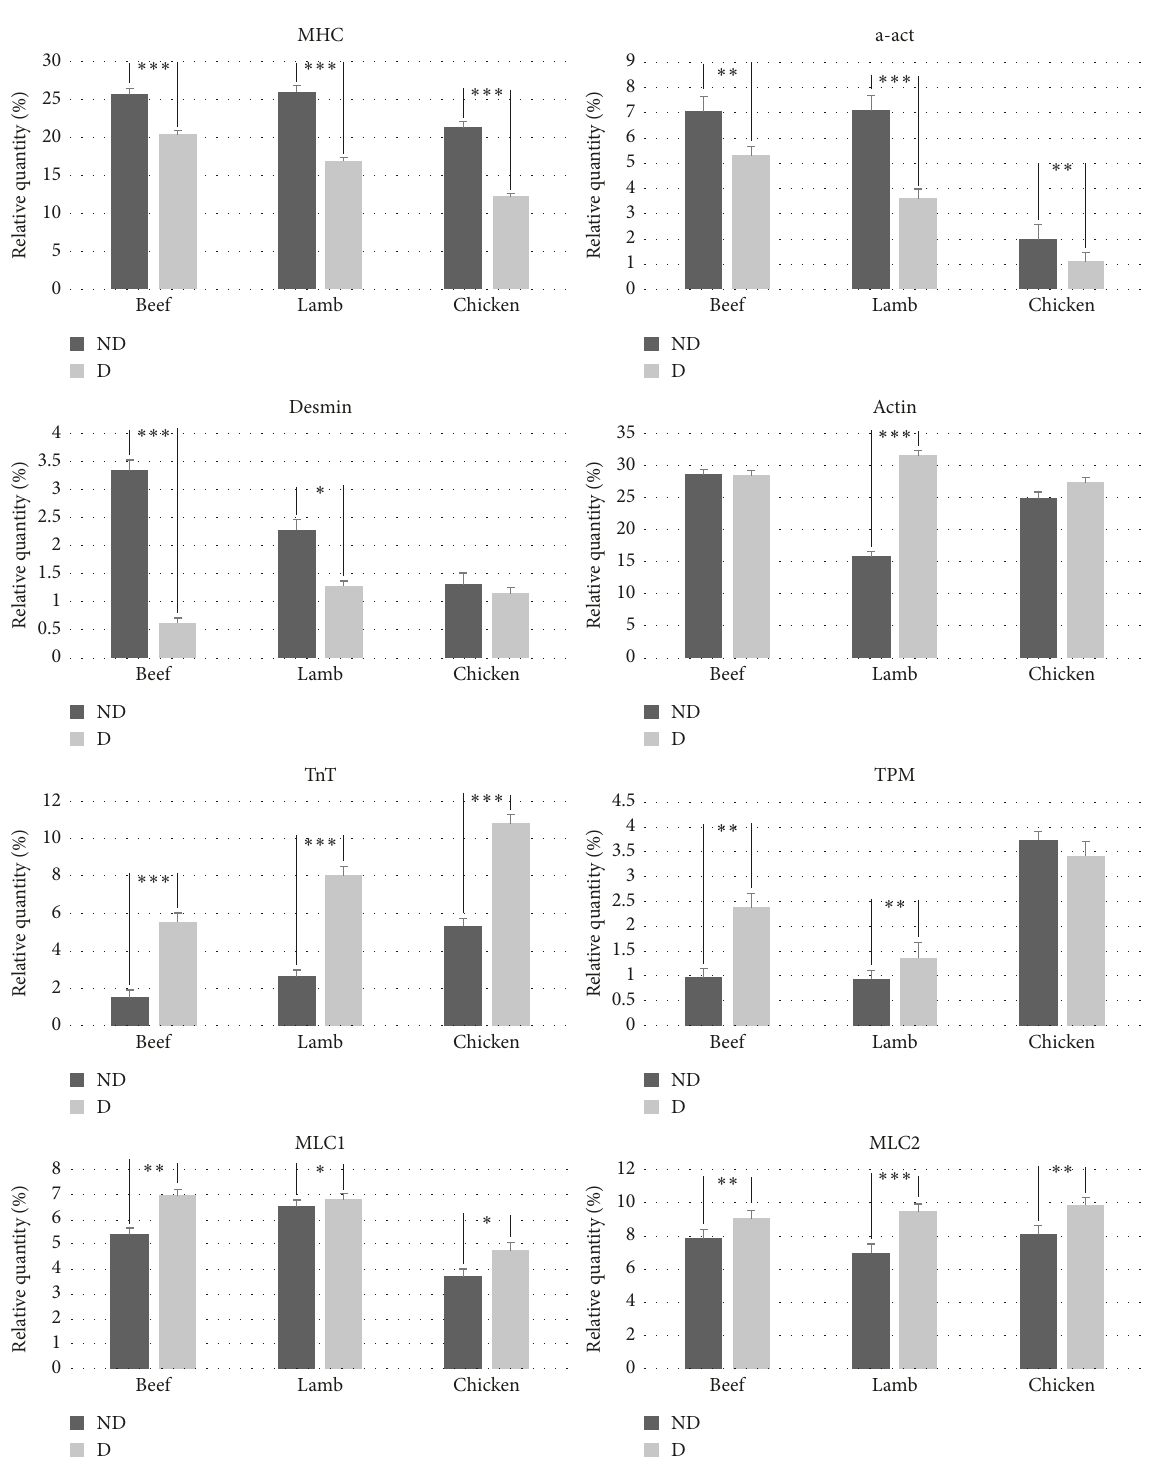
Figure 5: Percentage of the main myofibrillar proteins from beef, lamb, and chicken samples extracted with denaturing and nondenaturing solutions (D � denaturing; ND � nondenaturing; MHC � myosin heavy chain; a-act � α -actinin; TnT � troponin T; TPM � tropomyosin; MLC1 � myosin light chain 1; MLC2 � myosin light chain 2; ∗ P < 0 . 05; ∗∗ P < 0 . 01; ∗∗∗ P < 0 . 001) (means ±